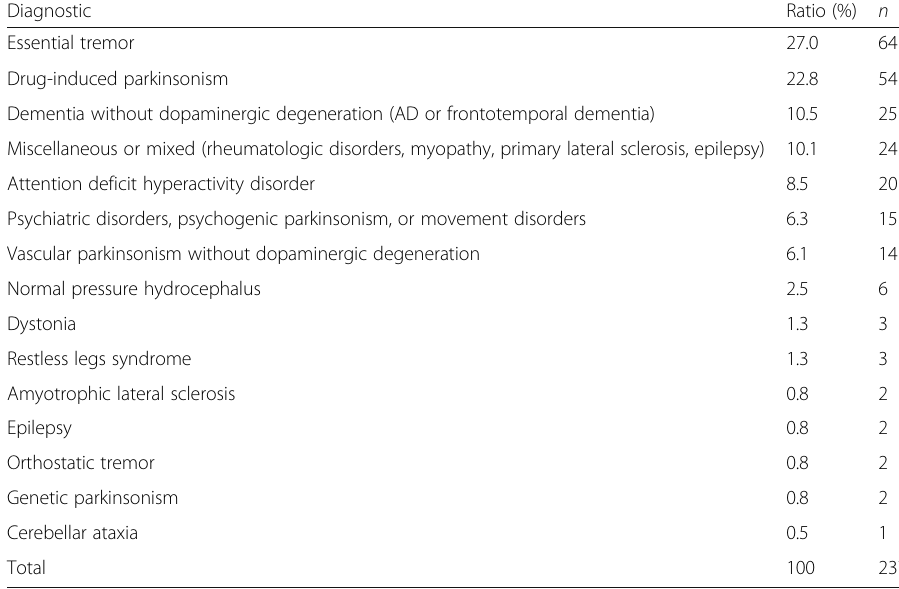
Table 1 Final diagnoses of subjects included in the generated databases Diagnostic Essential tremor